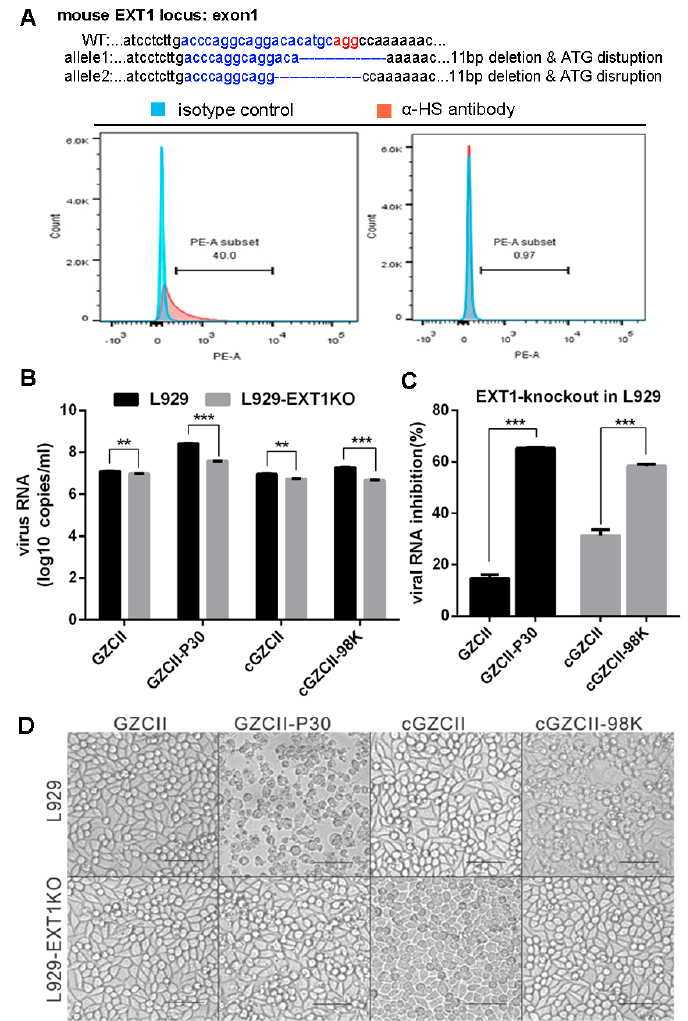
Figure 6. Replication of EV71-GZCII variants in wildtype and EXT1-knockout L929 cells. Cloned L929-EXT1KO cells were genotyped to confirm gene disruption or analyzed by flow cytometry to detect HS expression ( A ). Normal mouse IgM was used as an isotype control. Replication and cytotoxicity of GZCII mutants in HS-depleted cells. L929 and L929-EXT1KO cells ( B ) were infected with GZCII variants (MOI = 0.1). Viral RNA copy numbers and percent inhibition were determined at 24 h post-infection by qRT-PCR. Viral RNA copy numbers and percent inhibition by EXT1KO were determined ( C ). Images of infected wild-type or EXT1 knockout cells were acquired at 24 h post-infection ( D ) to observe the CPE induced by GZCII variants. Scale bar: 200 µ m. (**: p < 0.01; ***: p <